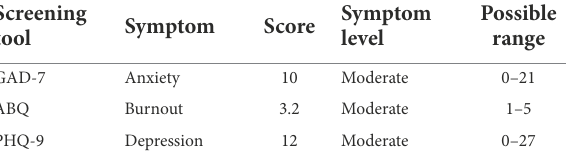
TABLE 1 Results of client’s intake survey. Screening tool